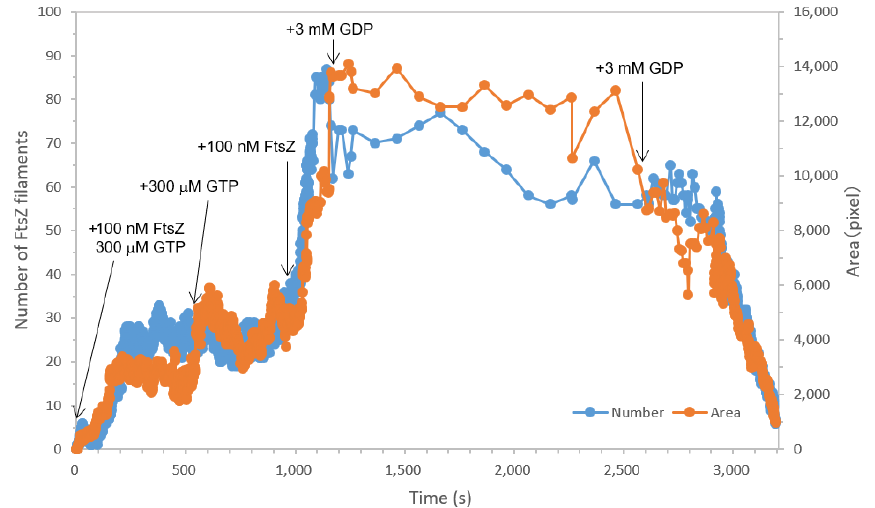
Figure 3. Time-course graph of the number (blue) of FtsZ filaments and the area (orange) covered with FtsZ filaments shown in Figure 2. Note that the time course is not completely continuous because of the intervals for adding samples and changing settings.